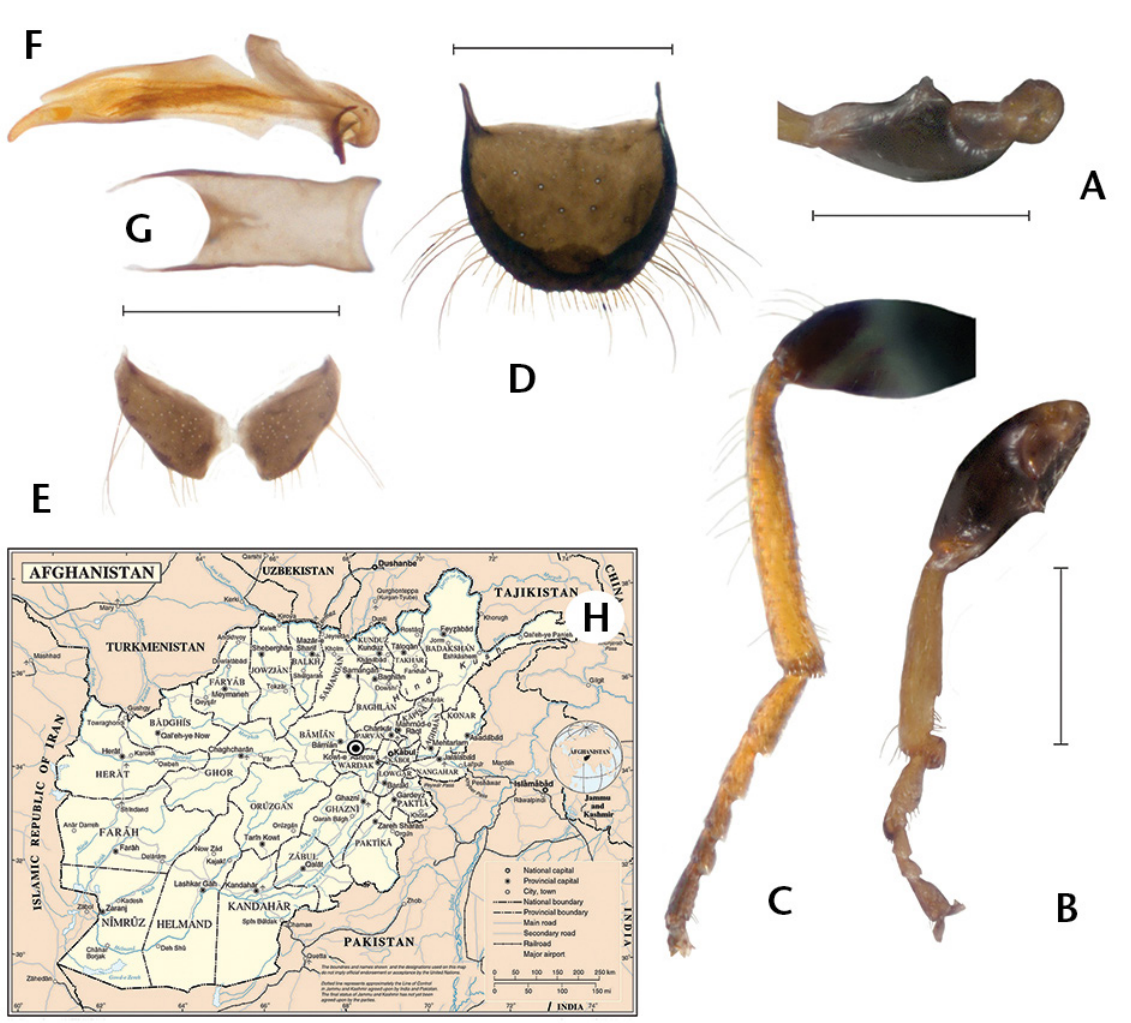
Fig. 2. Pectotibialis paghmanensis Tshernyshev gen. et sp. nov., holotype, ♂. A . Femur of left anterior leg. B . Left anterior leg, ventral view. C . Left intermediate leg, ventral view. D . Pygidium. E . Ultimate abdominal ventrite. F . Aedeagus, dorsal view. G . Tegmen. H . Distribution map. Scale bars: 0.5